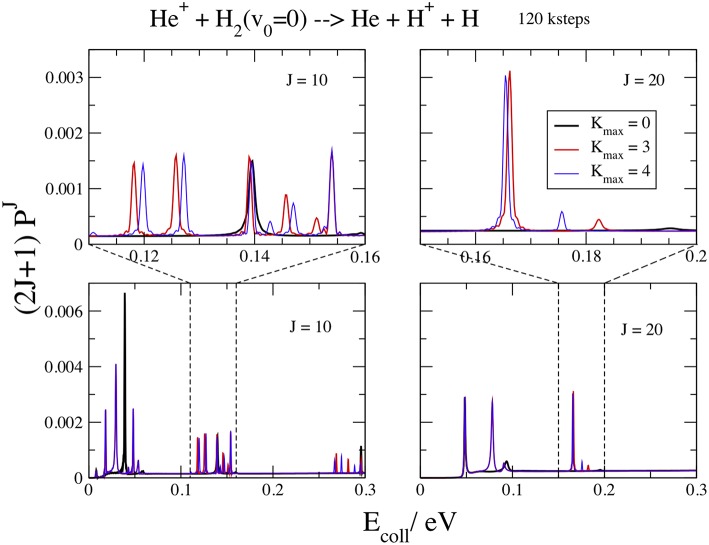
v0 = 0; J = 10, 20; kstep = 120. Convergence of the opacities (2J+1)Pv0J with respect to Kmax.